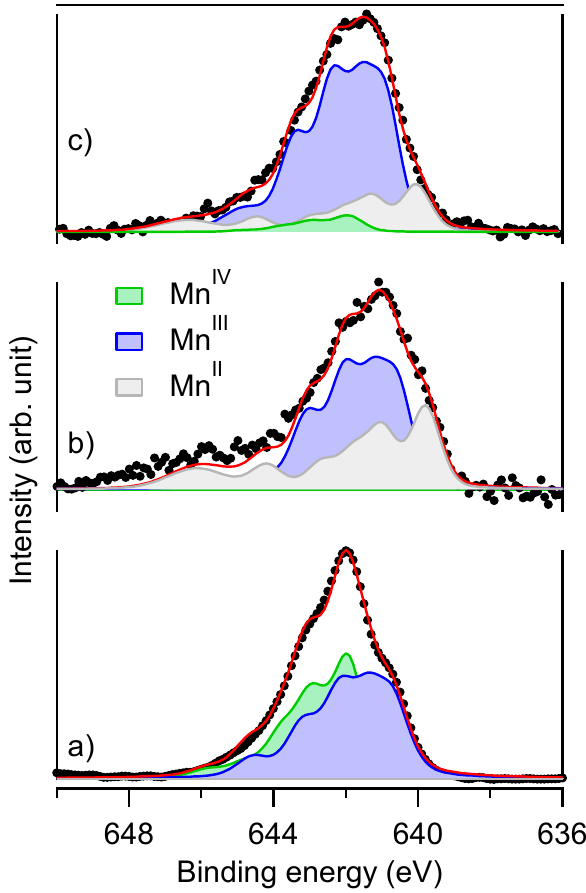
Figure 4. Mn2p 3/2 XPS spectra of ( a ) as prepared birnessite, ( b ) R06B02F and ( c ) R06B05F. Figure 4. Mn2p 3 / 2 XPS spectra of ( a ) as prepared birnessite, ( b ) R06B02F and ( c )